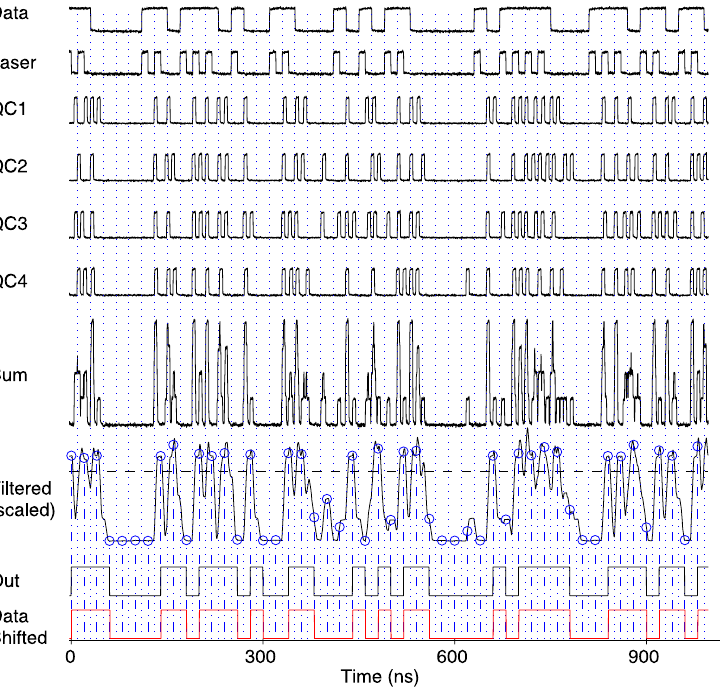
Figure 8. Analog processing of the 4 quencher circuits (QC) output data for 50 Mbit/s RZ at an optical power of 7.5 nW. The signals for a sequence of 50 bits were exported from Matlab. The signals Q1, Q2, Q3 and Q4 were measured simultaneously with the oscilloscope and imported into Matlab; their sum “Sum” was calculated by Matlab. The “Filtered” signal was scaled by a factor of 2 to make the curve progression better visible. The dashed line represents the threshold used by Matlab. The final output data (“Out”) are shifted by half a bit period to the right compared to the input data “Data” because the decision is made in the middle of each bit (denoted by the circles). The input “Data” sequence is shifted by half a bit (i.e. by 10 ns) to the right and repeated as “Data Shifted” to make a better comparison of output data “Out” and input “Data” possible.